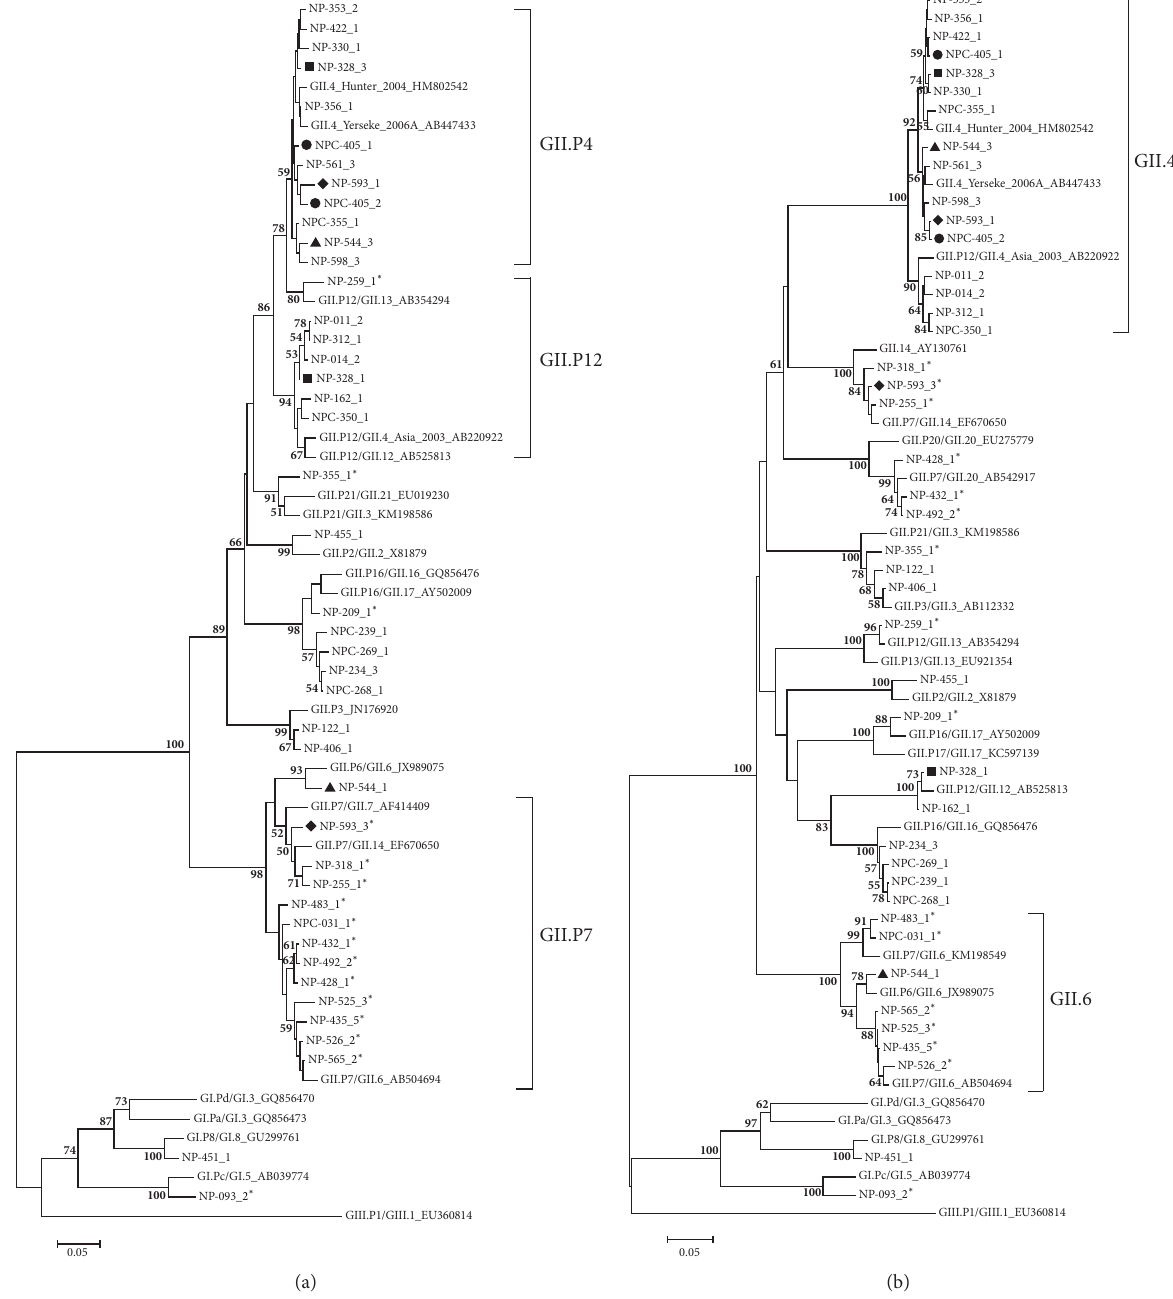
Figure 2: Phylogenic analysis of partial RNA-dependent RNA polymerase (RdRP) (a) and capsid genes (b) of norovirus from Cambodia pediatric samples during 2004–2006. Sample names are indicated as NP ###-# for case and NPC ###-# for control. -# after the sample name indicates colony number of clone for that sample. Recombination strains are indicated by ∗ at the end of sample name. Mixed infections from same sample are indicated with similar symbol ( ◼ for NP-328, e for NPC-405, 󳵳 for NP-544, and Q for